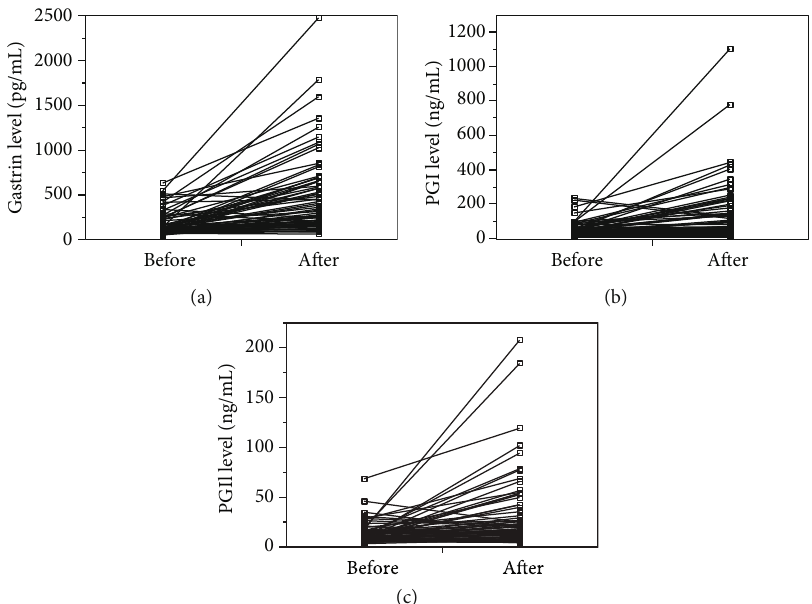
Figure 2: Serum levels of gastrin (a), pepsinogen I (PGI) (b), and pepsinogen II (PGII) (c) before and after administration of a proton pump inhibitor or potassium competitive acid blocker. Table 2: Comparison of gastrin, PGI, and PGII levels before and after proton pump inhibitor/potassium competitive acid blocker administration. Before After P value Amount of change Gastrin